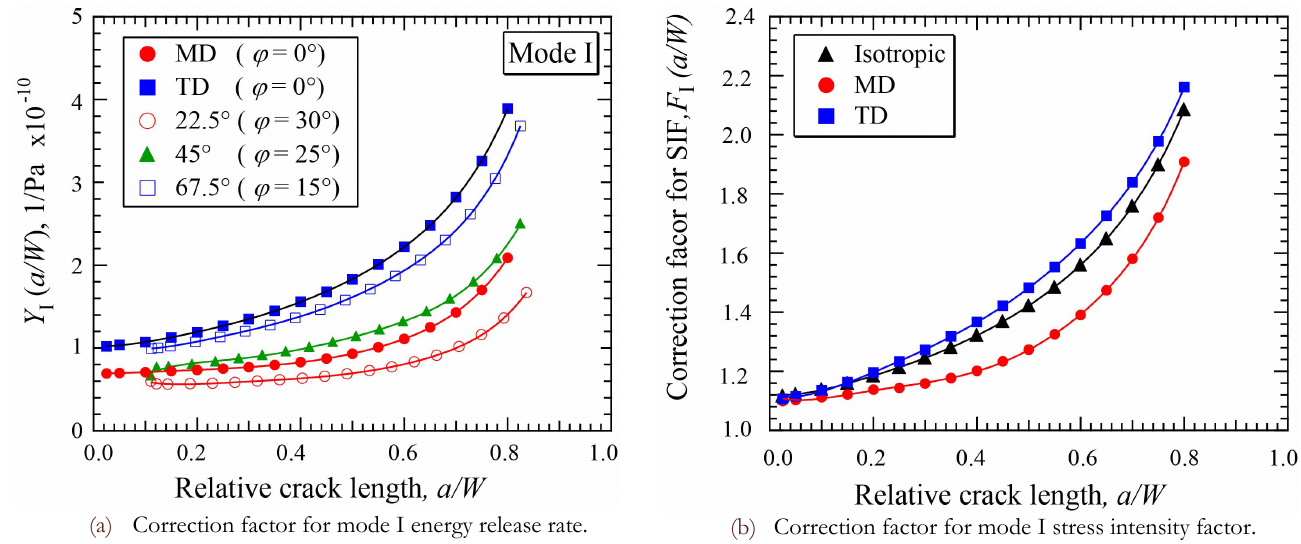
(a) Correction factor for mode I energy release rate. (b) Correction factor for mode I stress intensity Figure 10: Correction factors of mode I energy release rate and stress intensity factor.